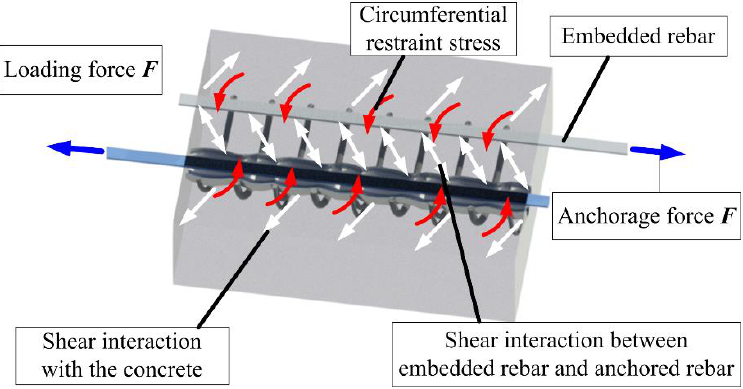
Figure 12. Bond mechanism of the short-lapped-rebar splices.